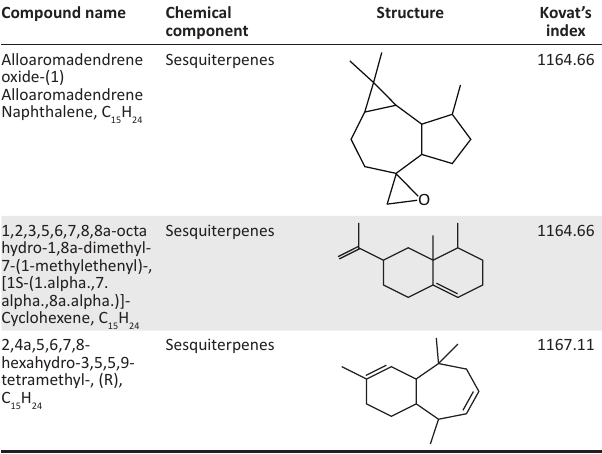
TABLE 1 (Continues...): Kovat’s index and structural formula of chemical compounds hydrodistilled from Clausena anisata.